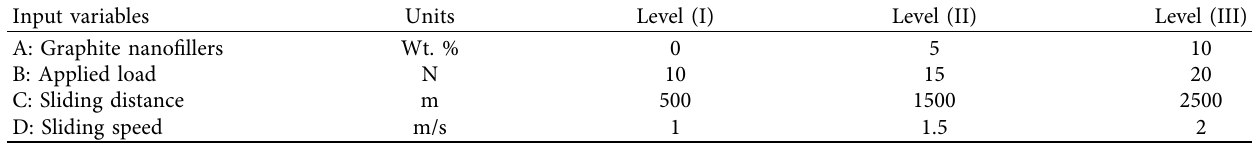
Table 3: Input variables and levels for nanocomposites.